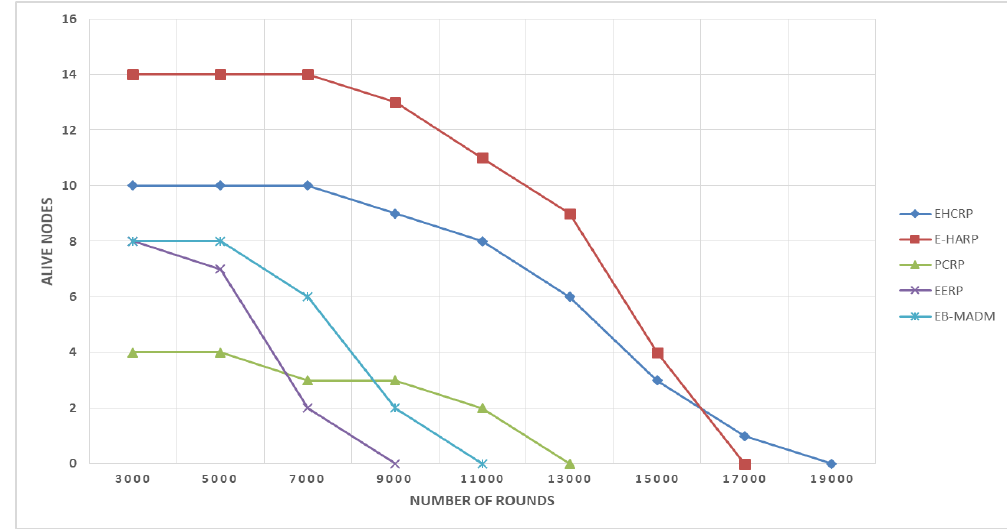
Figure 7. Breakdown of Network Stability (First-Node-Death).